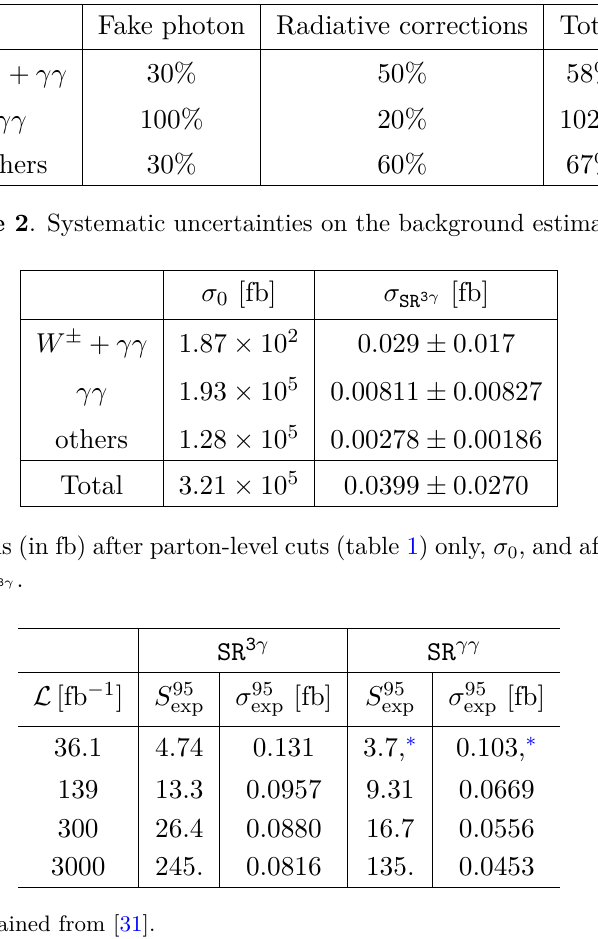
Table 4 . Upper limits at 95% C.L. on the number of signal events and the corresponding upper limits on the signal cross section for SR 3 γ and SR γγ